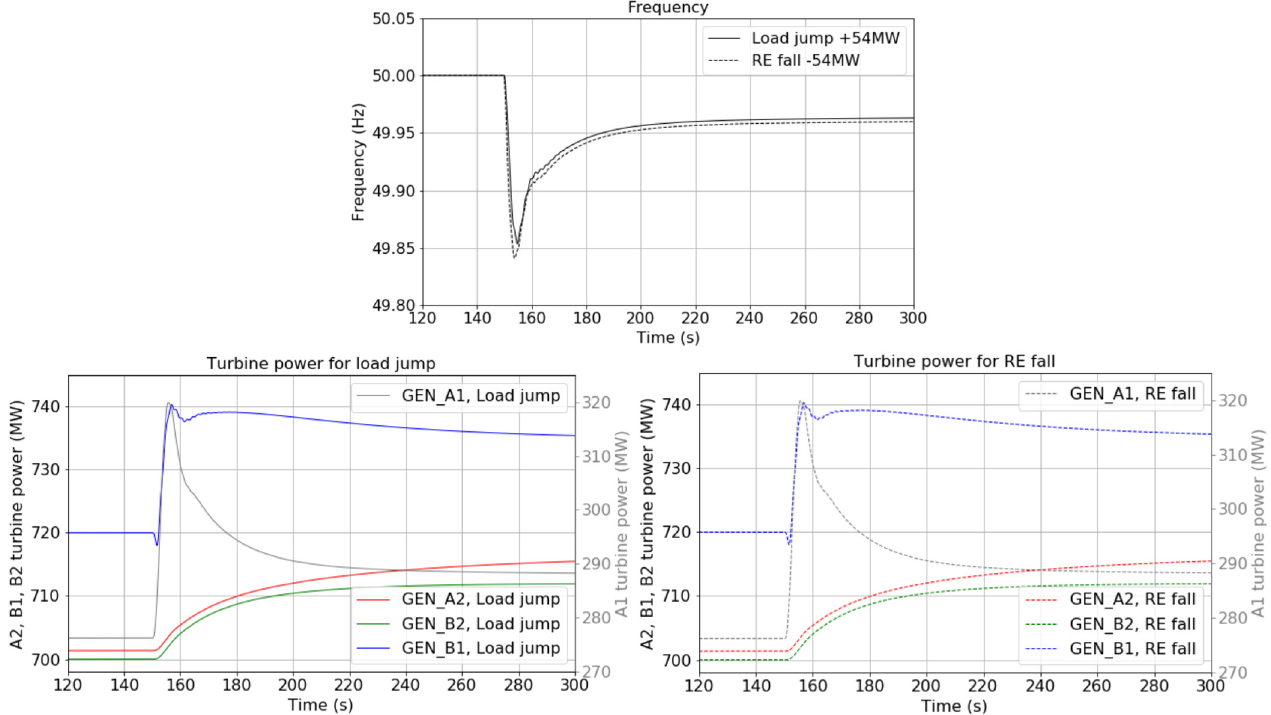
Fig. 3. Frequency (top) and turbine power (bottom) responses for two different 54MW power deviation (load jump in continuous line and RE fall in dotted line).